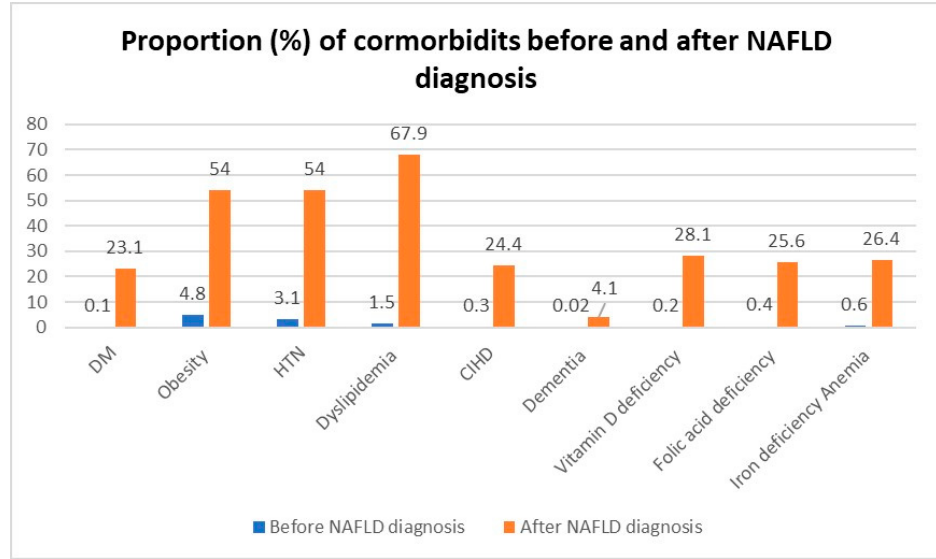
Figure 1. Timeline of comorbidities diagnosis compared to NAFLD.